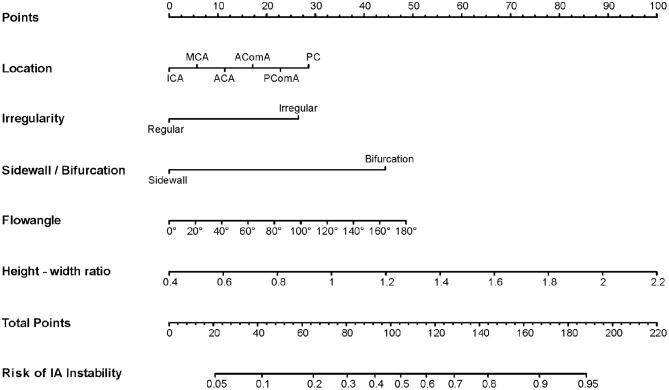
A nomogram to estimate the risk of small aneurysm instability based on preoperative clinical and morphological risk factors. The nomogram was developed in the derivation cohort based on five independent risk factors: location, irregularity, sidewall/bifurcation type, flow angle, and height-width ratio. To use the nomogram, find the position of each variable on the corresponding axis, draw a line to the points axis for the number of points, add the points from all of the variables, and draw a line from the total points axis to determine the risk of aneurysm instability at the lower line of the nomogram.